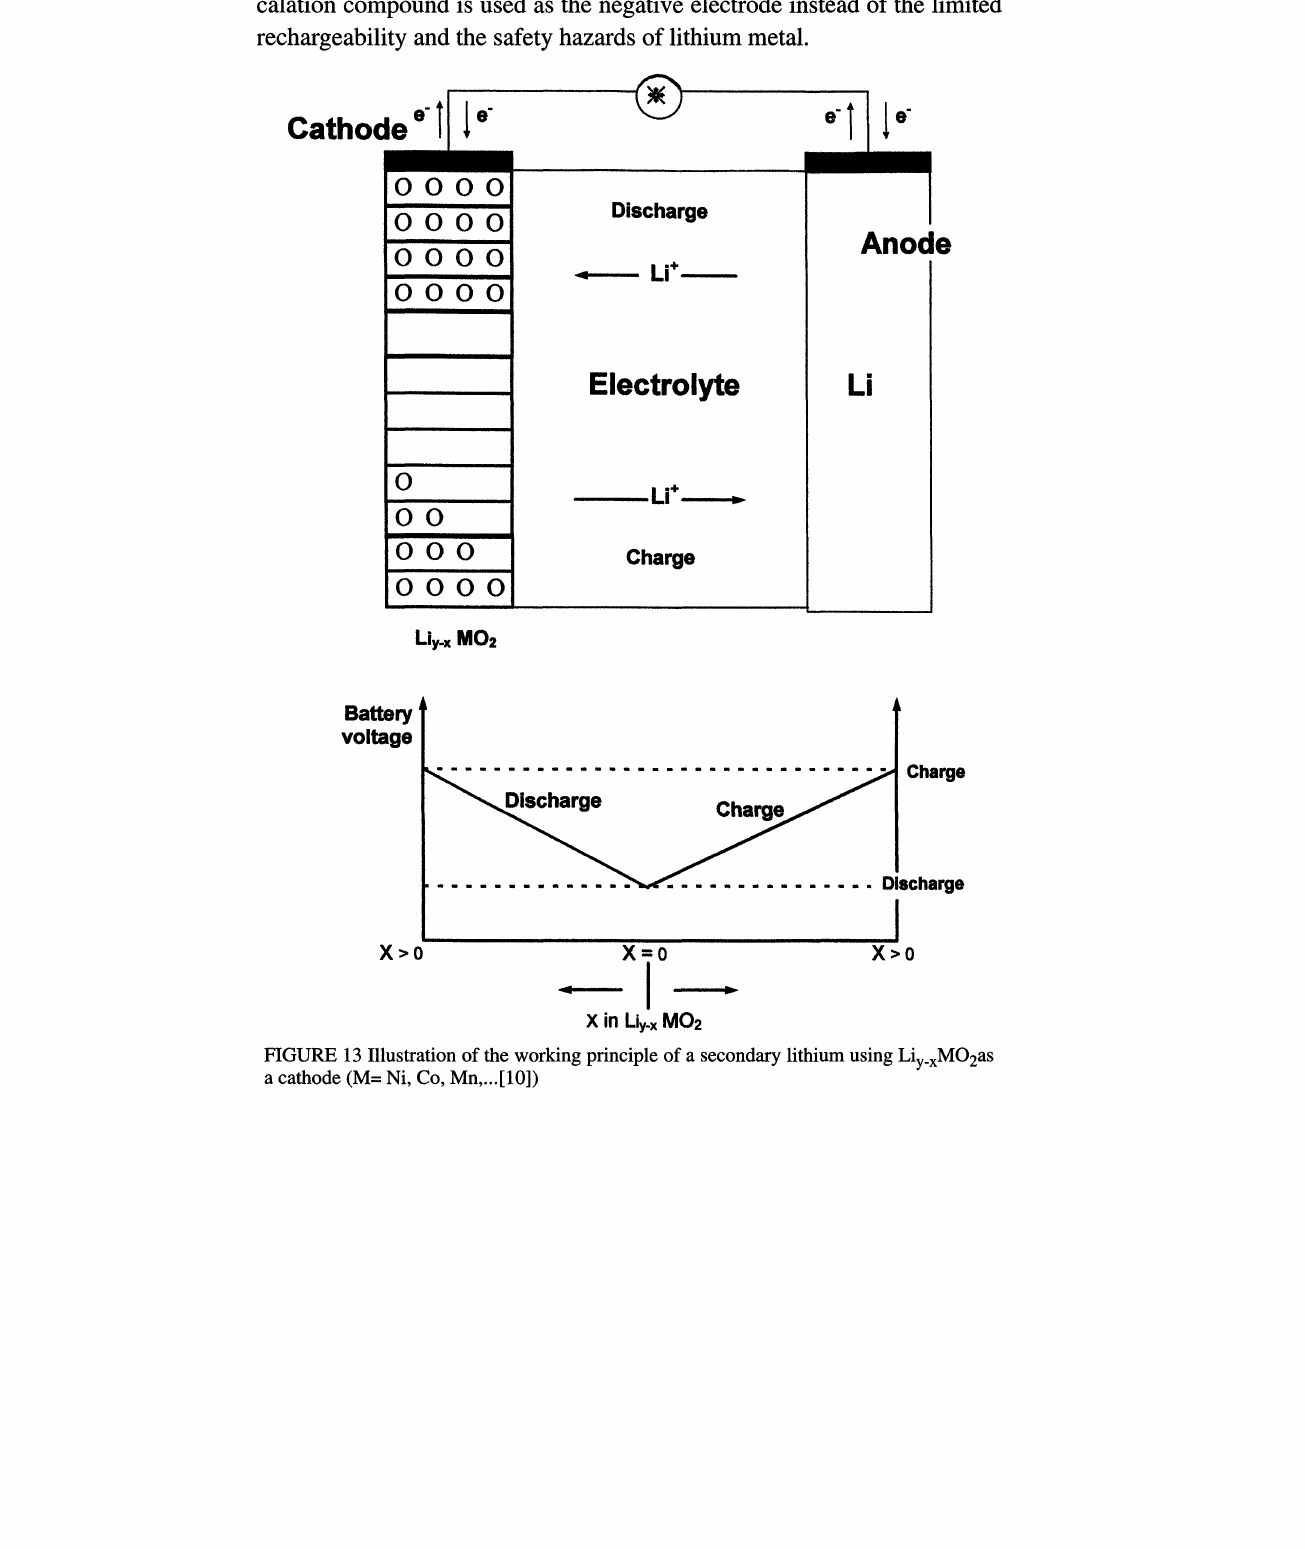
FIGURE 13 Illustration of the working principle of a secondary lithium using Liy.xMO2as a cathode (M= Ni, Co, Mn